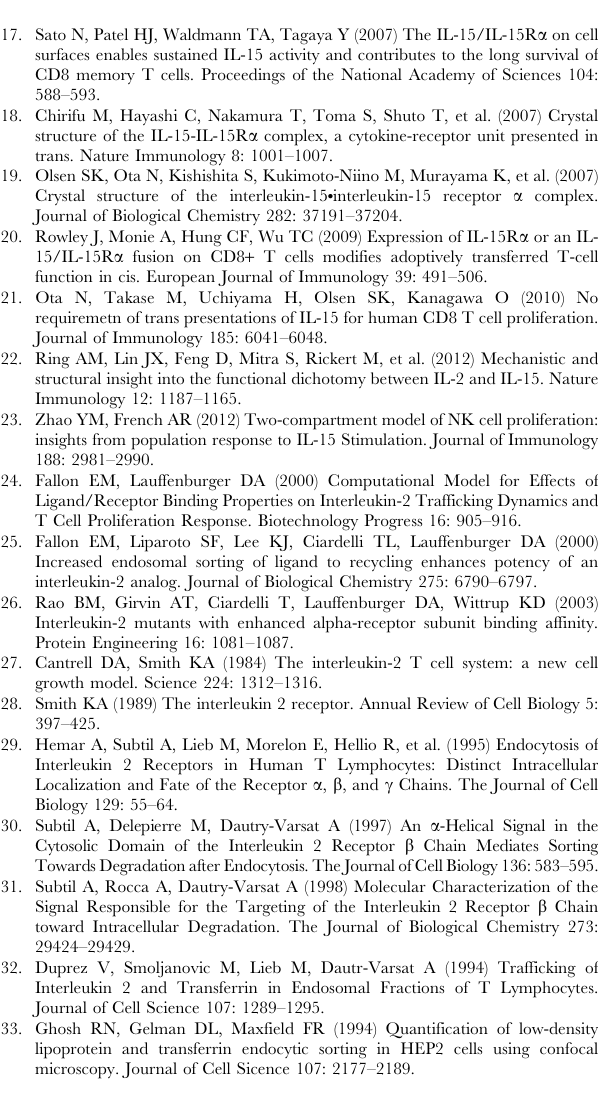
Figure S6 Gaussian distribution of the CFSE intensities of dividing NK cells. The CFSE intensity profiles of dividing NK cells stimulated by 9, 25, and 75 ng/ml of IL-15 were shown for ( A ) 48 hours, ( B ) 61 hours, and ( C ) 78 hours of stimulation. Undivided NK cells were excluded, and the CFSE profiles (black curves) represented the sum of different dividing cohorts. Each CFSE profile was fit with a Gaussian curve (red curves) using OriginPro 7.5 software, and the R 2 value was shown in each panel. These results were representative of three to four independent